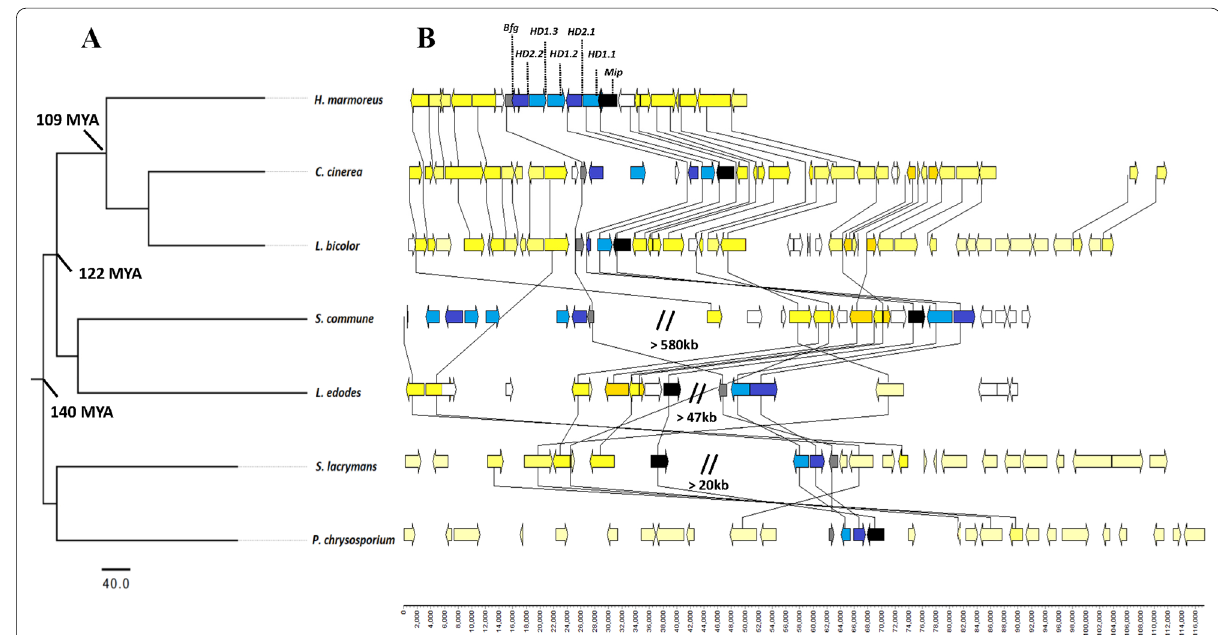
Fig. 4 The phylogenetic trees of different strains of basidiomycete and collinearity analysis of genomic regions containing the HD mating type loci. The Mip and Bfg genes are displayed with black and brown arrows, respectively. HD1 and HD2 genes shown as sky blue and blue arrows, respectively. Yellow are representative other genes, non-mating A local genes